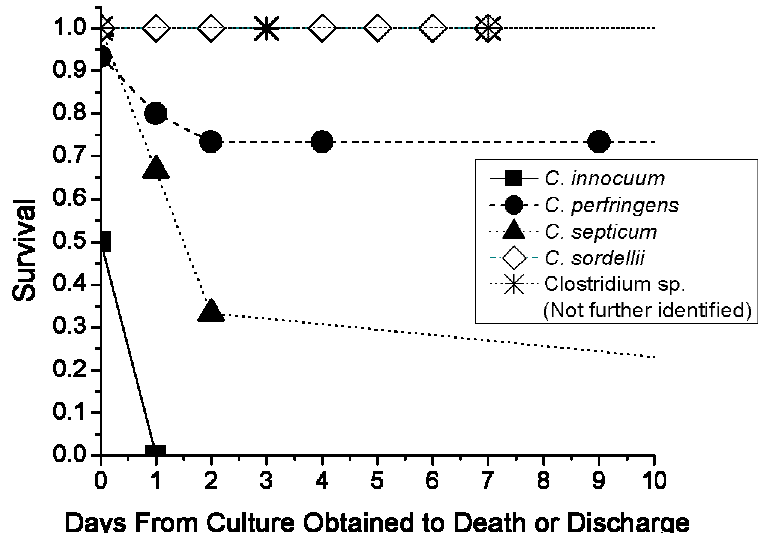
FIGURE 1. Kaplan-Meier survival plot of patients with CB vs. days after blood cultures were obtained. Note steep drop in survival at 2